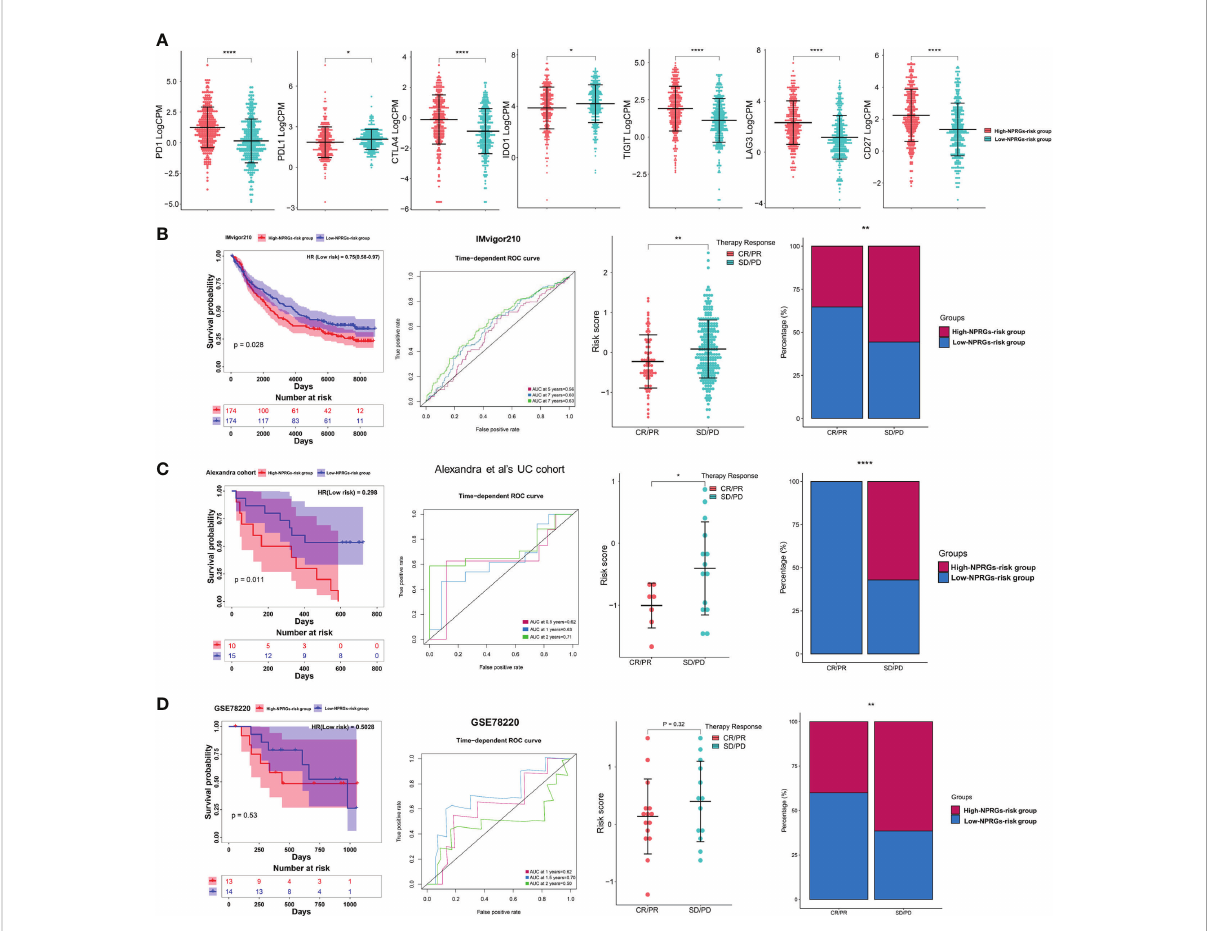
FIGURE 6 (A) The immune checkpoints ’ expression in the high- or low-NPRGs-risk group of TCGA-KIRC dataset. (B) Validation of the NPRGs risk signature in the IMvigor210 cohort with the survival analysis, ROC curves analysis, and immune therapy response analysis. (C) Validation of the NPRGs risk signature in the UC cohort of Alexandra et al. with the survival analysis, ROC curves analysis, and immune therapy response analysis. (D) Validation of the NPRGs risk signature in the GSE78220 cohort with the survival analysis, ROC curves analysis, and immune therapy response analysis. CR, complete response; PR, partial response; SD, stable disease; PD, progressive disease. *p-value < 0.05, **p-value < 0.01, ****p-value <